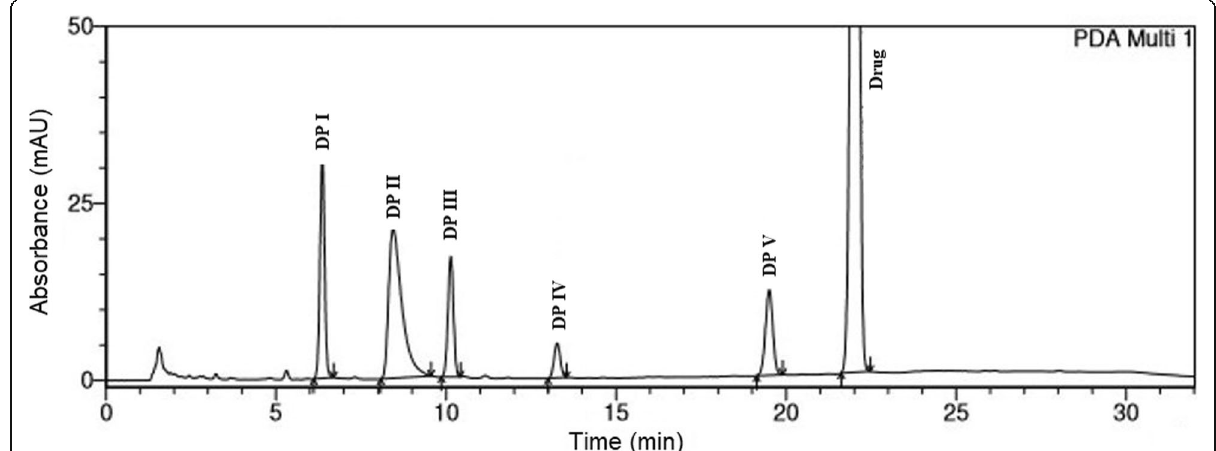
Fig. 2 Chromatogram showing separation of febantel and its degradation products (DP I, II, III, IV, and V in order of elution)